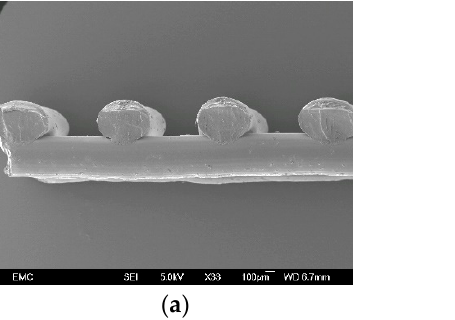
Figure 1. Schematic of the fused filament fabrication technology.